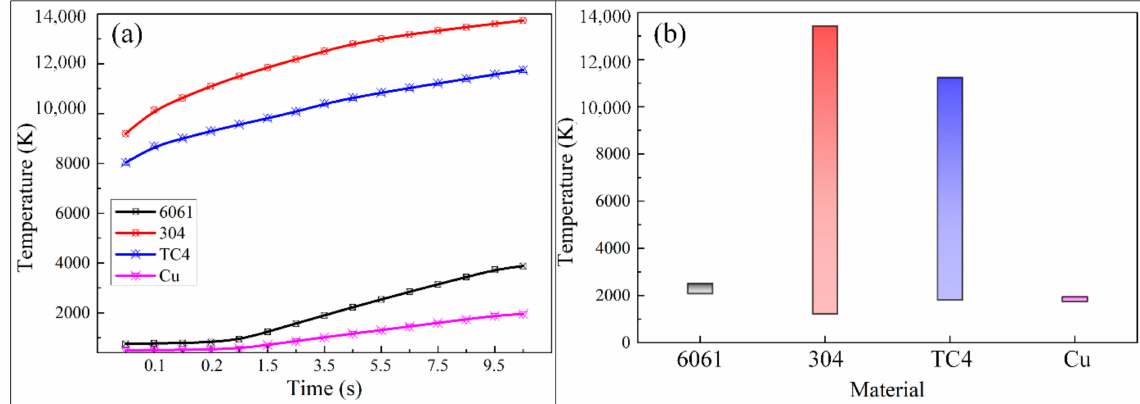
Figure 8. Simulation of the internal heat accumulation process of the material after the water jet-guided laser fixed-position drilling: ( a ) the change in temperature with processing time, ( b ) temperature difference at the end of processing (unset “element birth and death”).